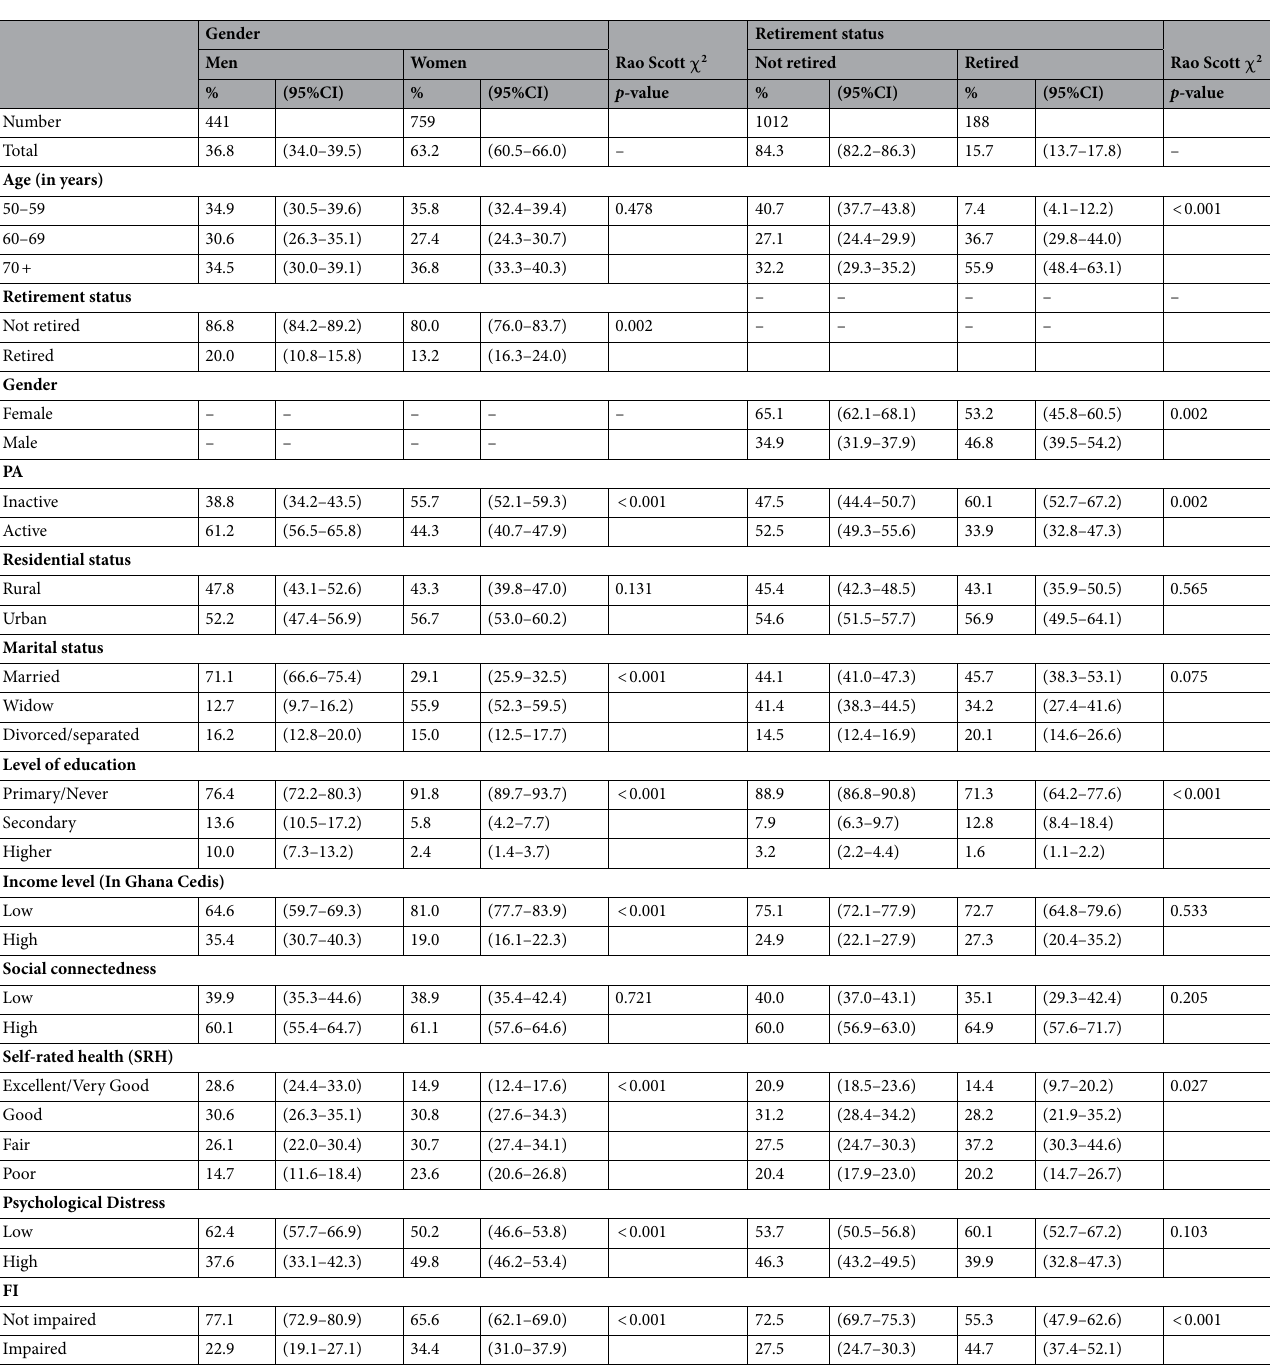
Table 2. Bivariate distribution of demographic and health-related characteristics by gender and retirement status ( N = 1201). FI—functional impairment; AP—physical activity; SRH—self-rated